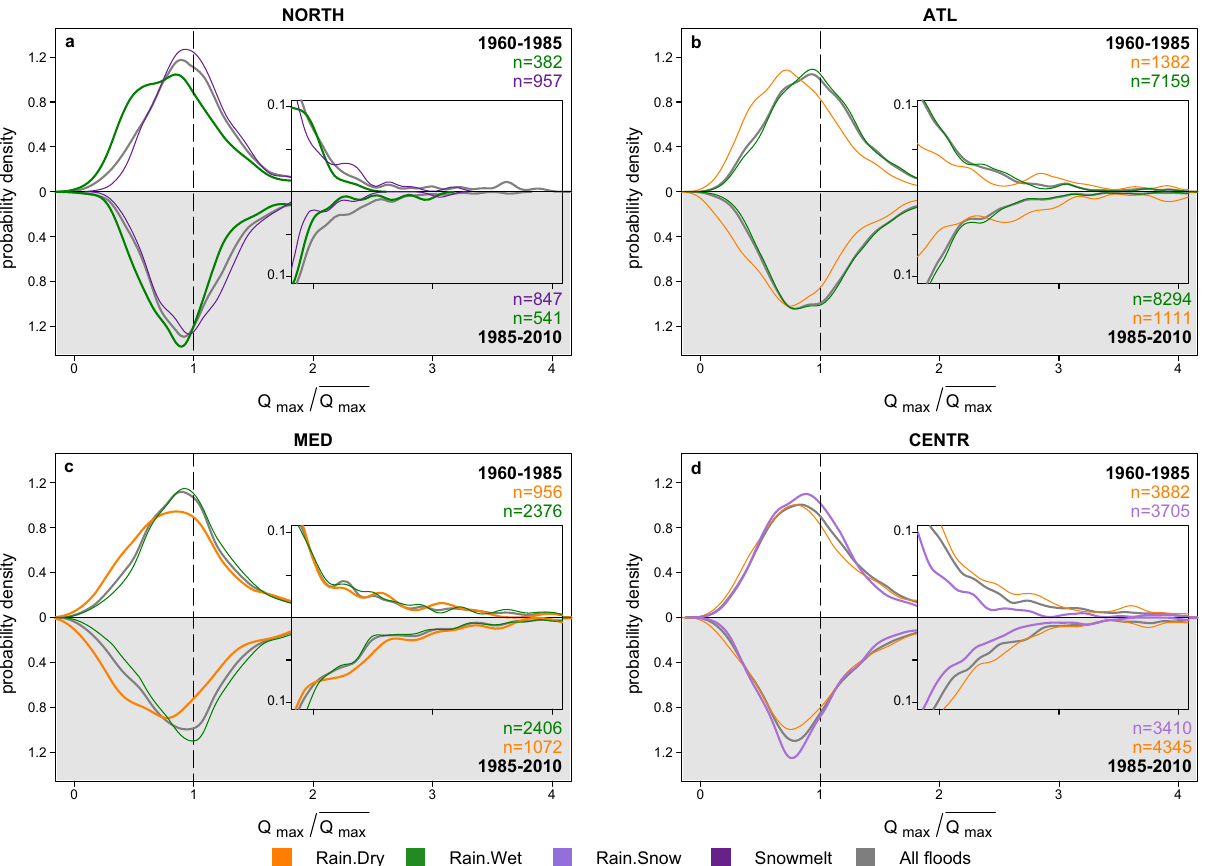
Fig. 6 Comparison of regional fl ood probability distributions of fl ood generation processes aggregated for two different periods. a – d Regional kernel density estimates of fl ood magnitudes (Qmax scaled by mean maximum annual fl ood for each study catchment) aggregated for each region and fl ood generation process. Insets provide a zoom into the right tails of corresponding distributions. The right tails of probability density functions are only shown up to the value of 4 (four times the mean maximum annual fl oods). The signi fi cance of differences of fl ood magnitude distributions of fl ood generation processes aggregated for two different periods (1960-1985 (white background) and 1985-2010 (grey background)) is tested with the pairwise two-sided Kolmogorov-Smirnov test ( α = 0.01) applying a false discovery rate correction. Signi fi cant cases are displayed as thick lines. Differences between different fl ood generation processes within the same period are signi fi cant for all displayed cases ( α = 0.01) according to the pairwise two-sided Kolmogorov- Smirnov test with false discovery rate correction (see Supplementary Table 3). n is the number of fl ood events in each sample. Only fl ood generation processes that showed considerable changes in their regional frequency (Fig. 2) and have considerable deviations in their frequency during opposing modes of fl ood anomalies (Fig. 4b) are displayed. The remaining processes are displayed in Supplementary Fig. 10.